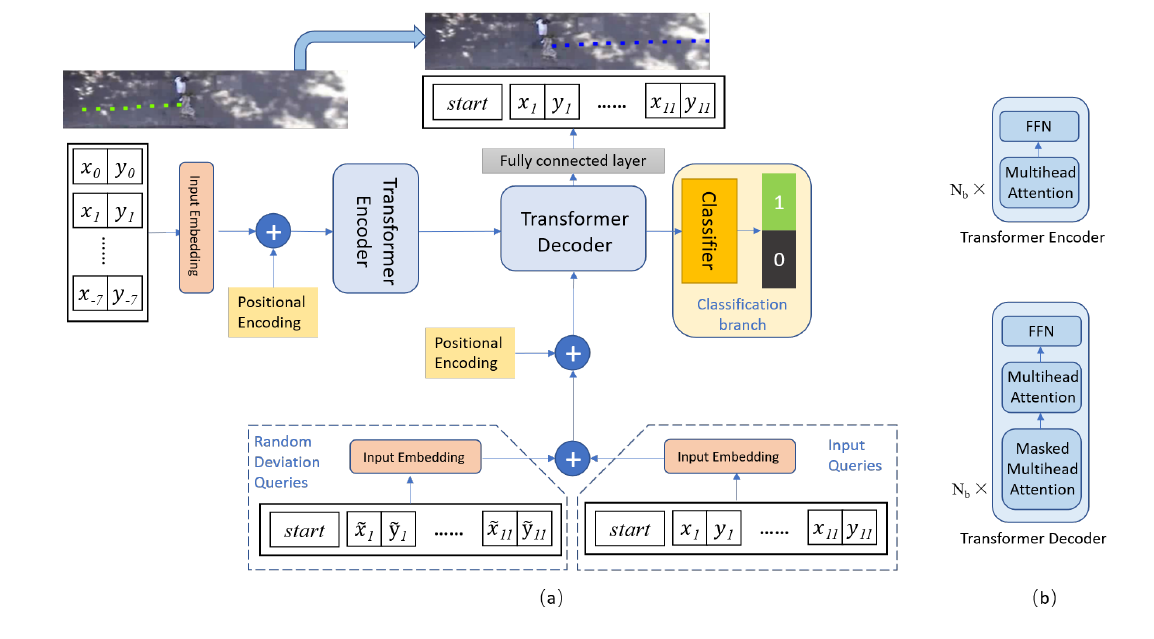
Figure 1. ( a ) The architecture of the overall framework of the proposed approach for pedestrian trajectory prediction. The framework is a transformer-based network assisted with random deviation queries and a classify branch to enhance performance. The observed pedestrian positions are fed to the network, and the network predicts the future trajectory. ( b ) The detail information of the encoder and decoder in the